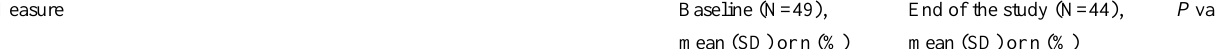
P valueEnd of the study